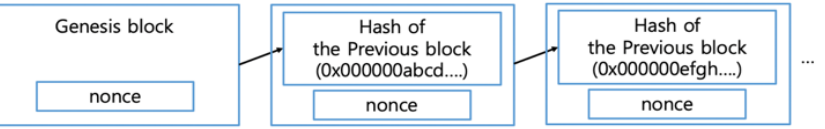
Figure 1. An example for the chained blocks structure.